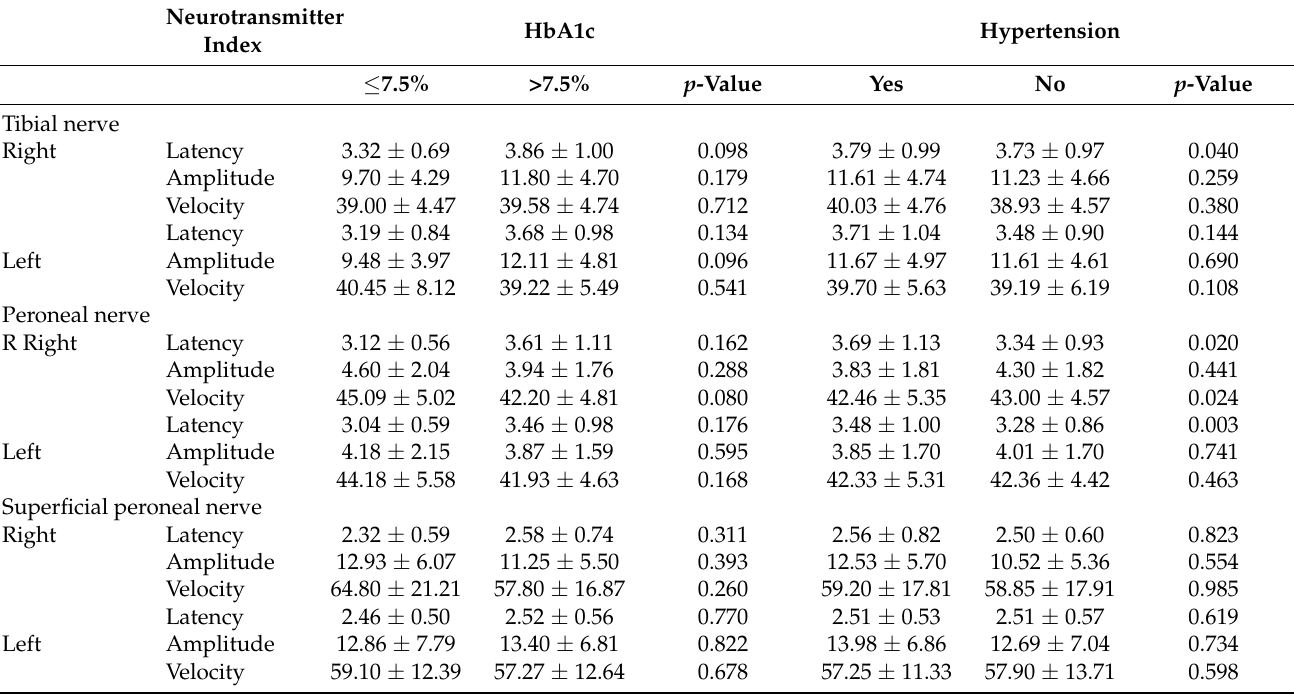
Table 7. Relationship between the index of tibial nerve, the peroneal nerve, and the superficial peroneal nerve with HbA1c and